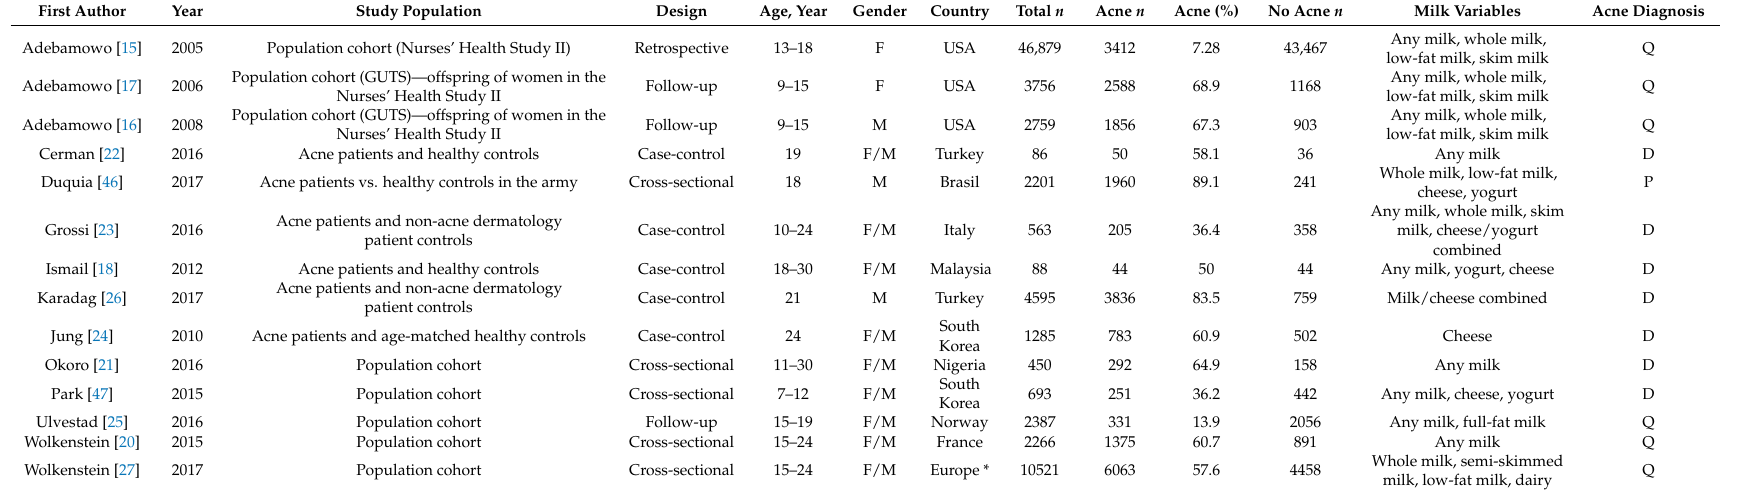
Table 1. Characteristics of included studies for the association of dairy intake with acne in children, adolescents, and young